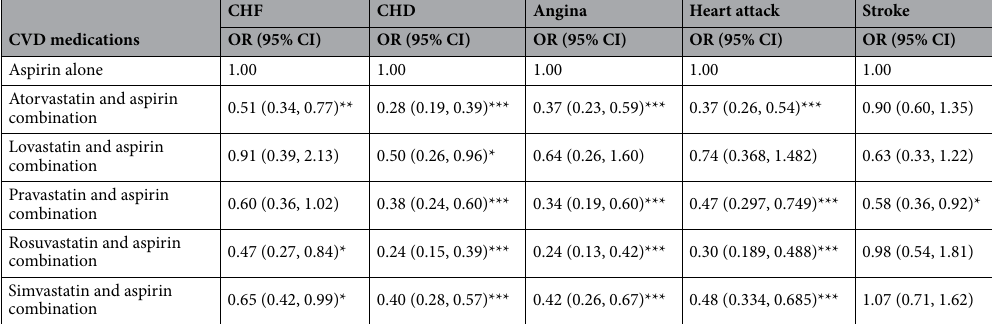
Table 3. Associations of aspirin alone compared to aspirin plus statin with the risk of individual CVD. Analysis was adjusted for age, gender, education level, race/ethnicity, marital status, family poverty-income ratio, hypertension, diabetes mellitus, smoker, alcohol user, body mass index, physical activity, total energy intake, high-density lipoprotein-cholesterol, total cholesterol, triglyceride, uric acid, creatinine, blood urea nitrogen, and hemoglobin. CVD cardiovascular disease, CHF congestive heart failure, CHD coronary heart disease, OR odd ratio, CI confidence interval. * P < 0.05, ** P < 0.01, *** P < 0.001 .